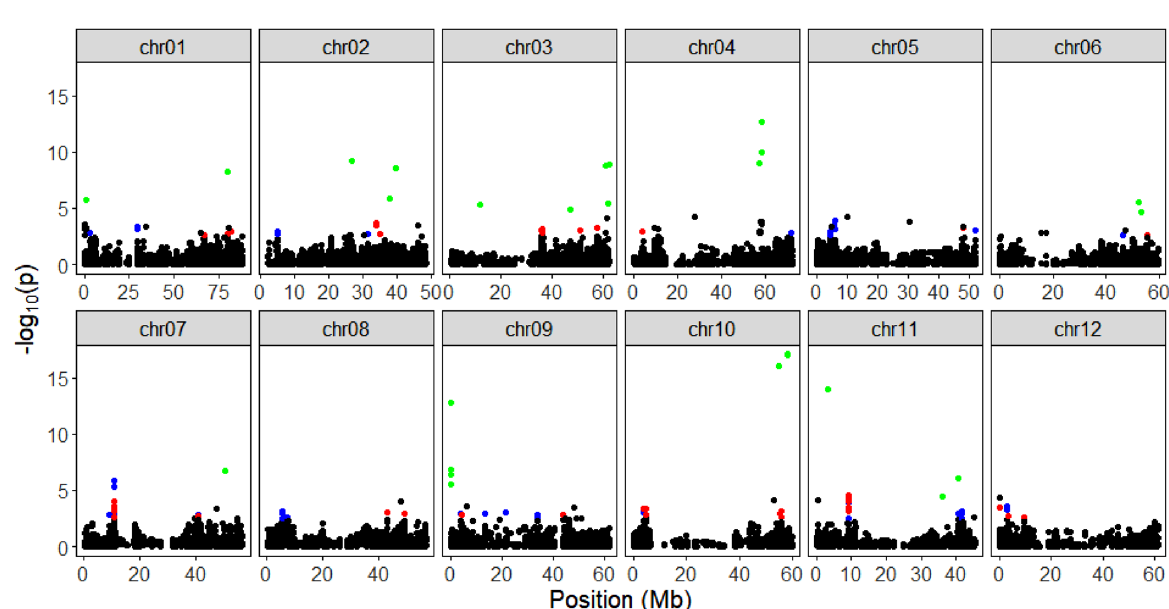
Figure 8. Distribution of standardized iHS scores in three groups of potatoes using rehh R package 75